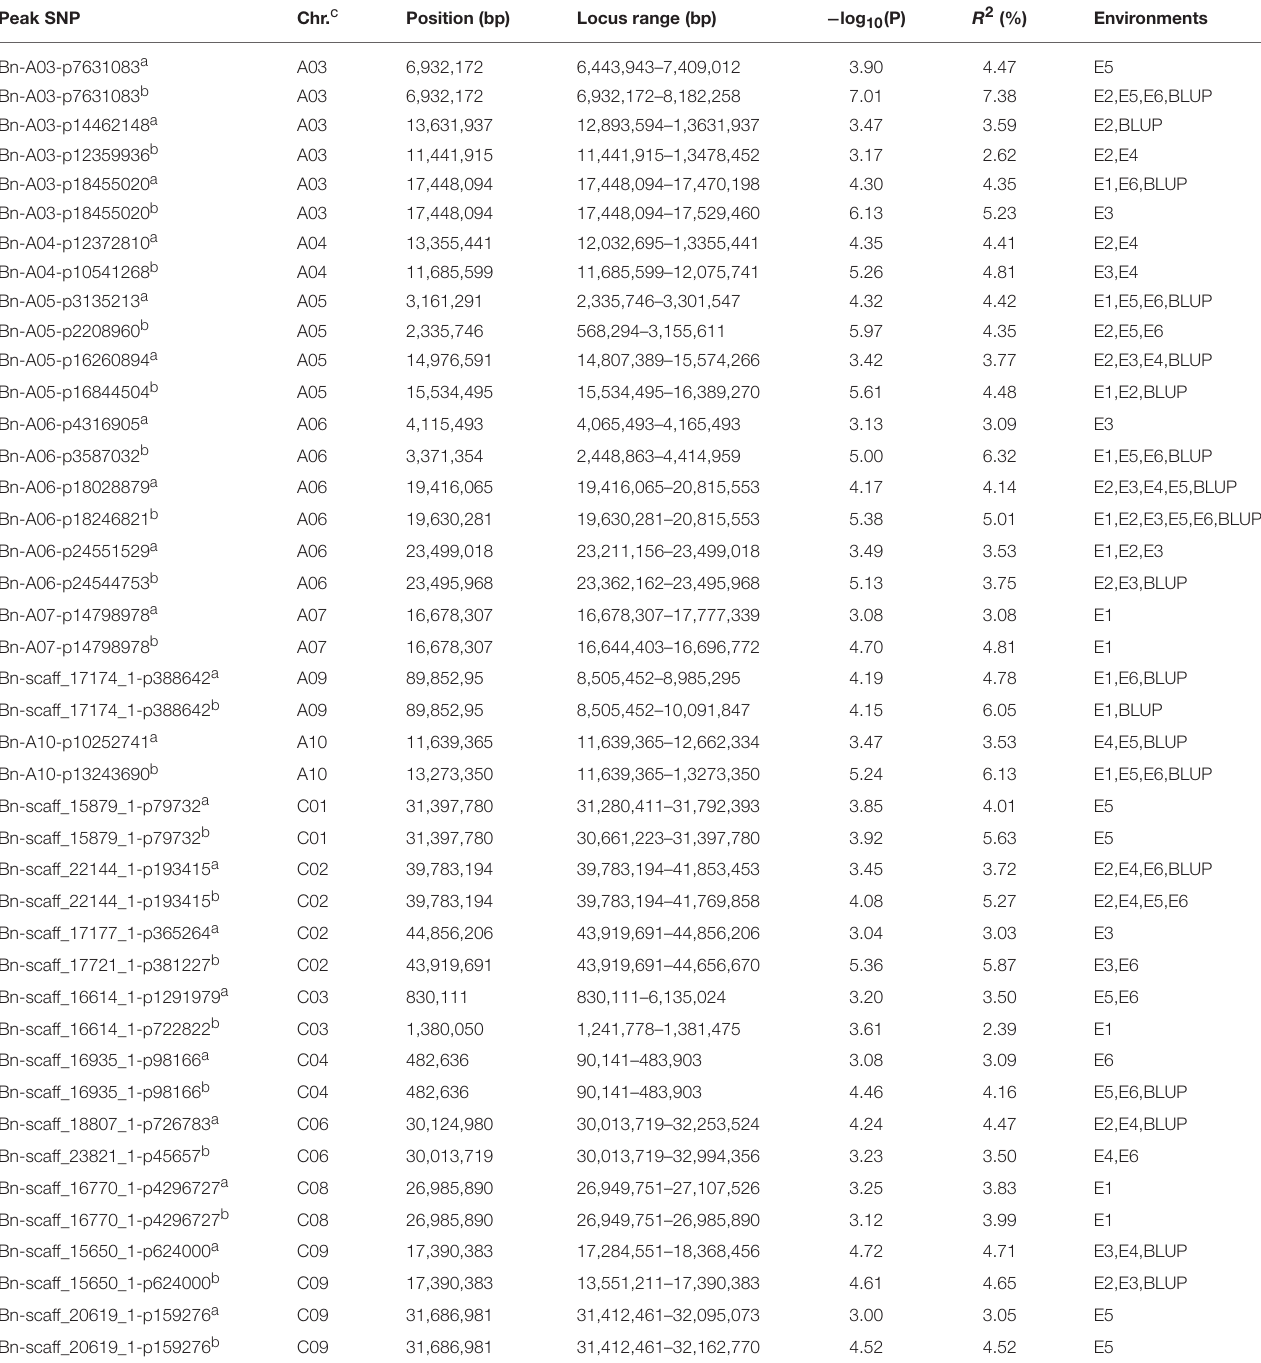
TABLE 6 | The common loci significantly associated with branch angle between MLM and MRMLM. Peak